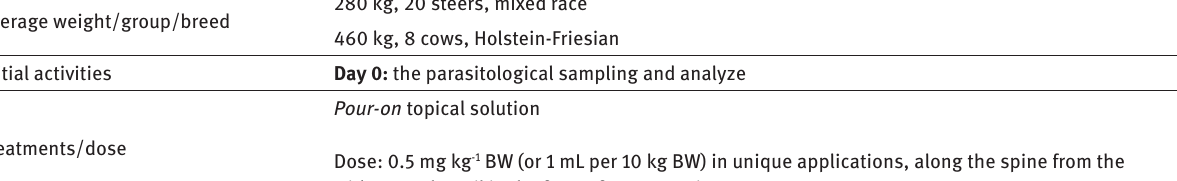
Table 2: Applied experimental scheme. Average weight/group/breed